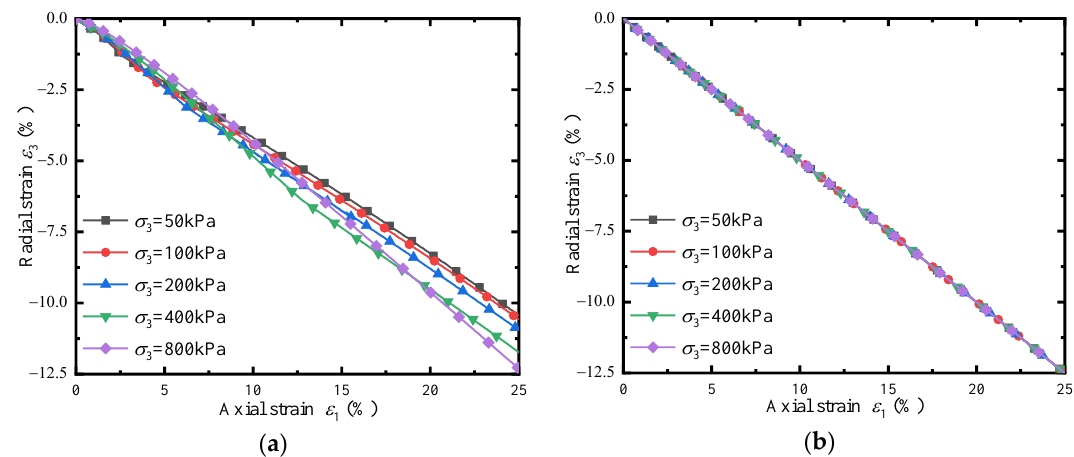
Figure 7. Relationships between axial strain and radial strain. ( a ) Drained. ( b ) Undrained.